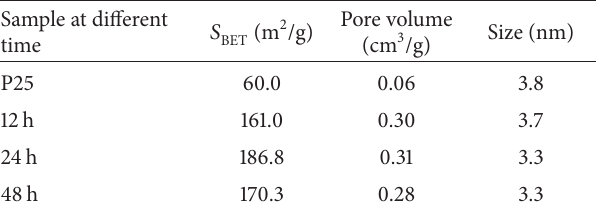
Table 2: BET analysis of the prepared titanate nanotubes at different time at constant temperature of 130 ∘